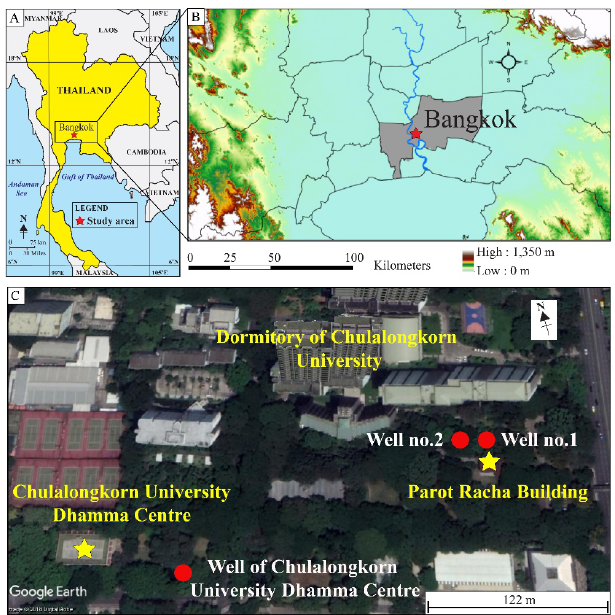
Figure 1. The location of installed GHP system: Index map of Thailand ( A ) and Chulalongkorn University (star) in Bangkok ( B ). Google Earth Map showing the location of Paraot Racha, well no. 1 and no. 2 in Chulalongkorn University and the nearest artesian well (Chulalongkorn University Dharma Centre) ( C